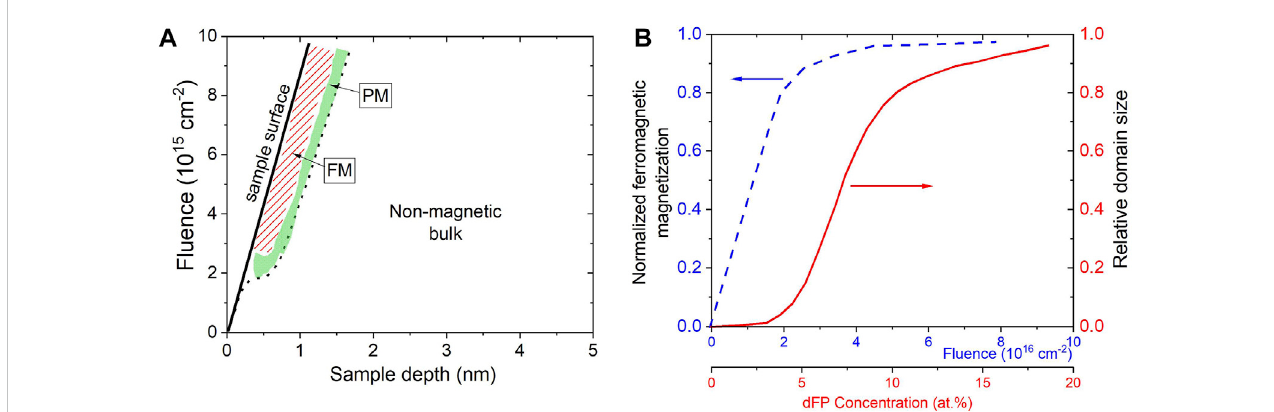
FIGURE 1 (A) Semiquantitativemagneticphasediagram( fl uencevssampledepth)foraTiO 2 anatasesampleirradiatedwithAr + ionsof200 eVenergyfollowingthe results of[25]. The straight line denotestheposition ofthesamplesurface, which shifts due to thesputtering.The red region istheferromagnetic (FM) region, and the green is a paramagnetic (PM) region. The dotted line represents roughly the transition region between a PM and a non-magnetic region, where the mean number of defects created by the irradiation is negligible. The dotted line can be considered the penetration depth of the irradiated ions. (B) Blue dashed line represents normalized ferromagnetic magnetization vs Ar + fl uence or the estimated dFP density in the TiO 2 anatase phase. Red line represents relative FM domain size vs fl uence or dFP concentration. The curves represent semiquantitatively the main theoretical results from [25] for the case of irradiation of Ar + ions with 200 eV energy in the TiO 2 anatase